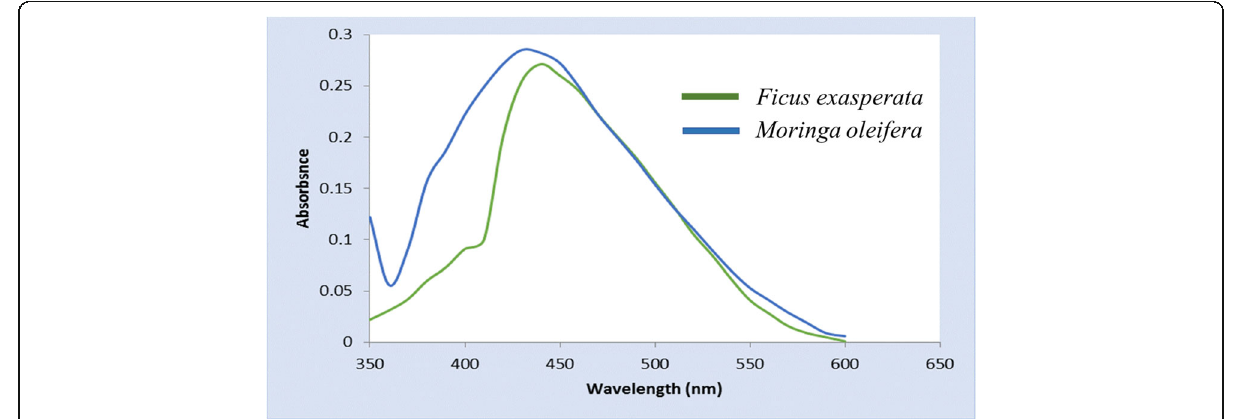
Fig. 3 UV-Vis absorption spectra of silver nanoparticles synthesized by Moringa oleifera (blue line) and Ficus exasperata (green